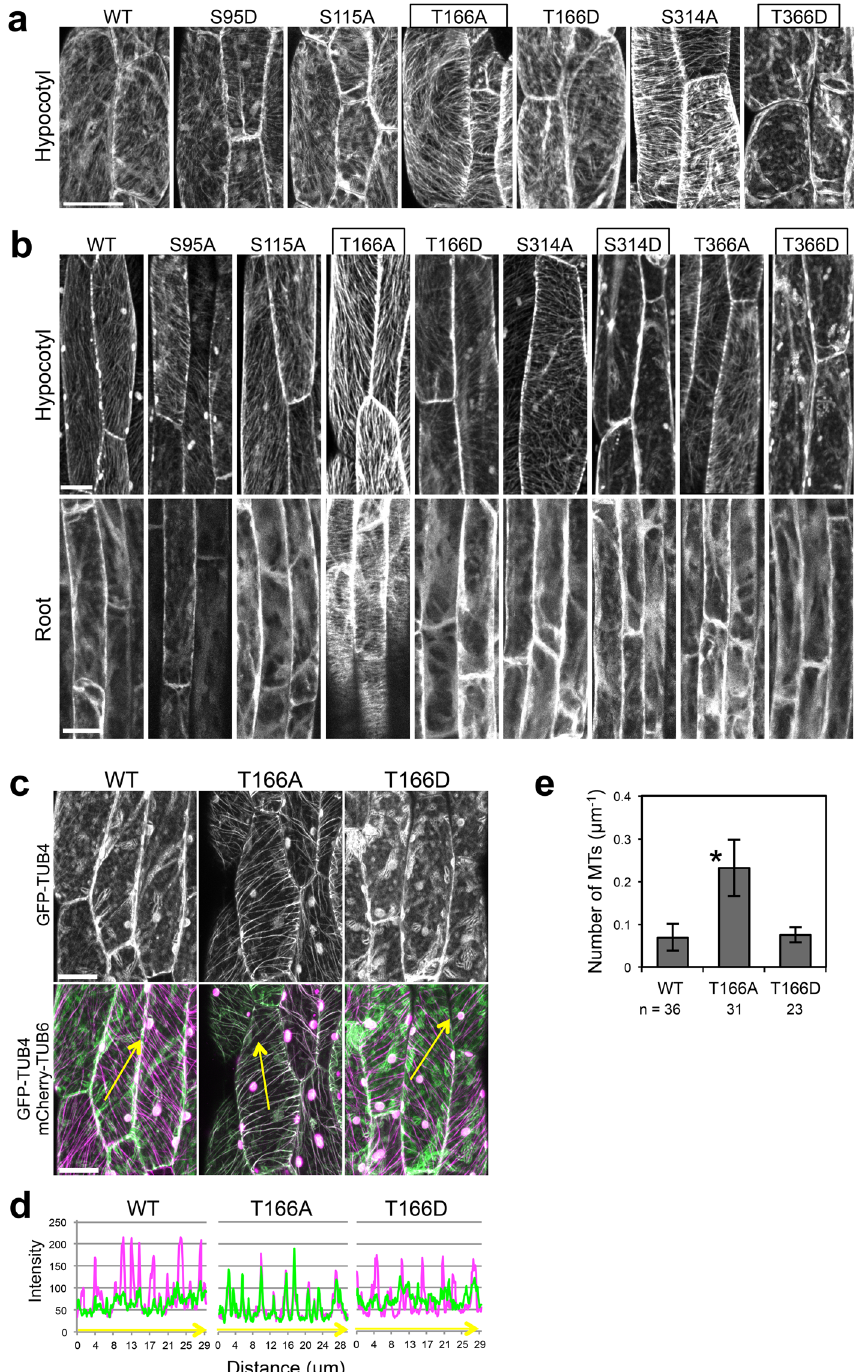
Figure 7. Involvement of Thr166 of β -tubulin in cortical microtubule depolymerization. ( a , b ) Subcellular localization of wild type TUB4 (WT) and mutated TUB4 proteins (S95A, S115A, T166A, T166D, S314A, S314D, T366A and T366D) fused with GFP at the N-terminus. GFP-TUB4 was constitutively driven by the CaMV35S promoter in ( a ) ( 35S:GFP-TUB4 ) or expressed under the TUB4 own promoter in ( b ) ( TUB4pro:GFP-TUB4 ). The scale bars represent 30 µ m in ( a ) or 20 µ m in ( b ). ( c ) Subcellular localization of wild type TUB4 (WT) and mutated TUB4 proteins (T166A or T166D) fused with GFP at the N-terminus (green). Cortical microtubules are visualized with mCherry-TUB6 (magenta). The scale bars represent 20 µ m. ( d ) Profiles of fluorescence intensity of GFP and mCherry along lines shown in ( c ). ( e ) Density of microtubules labeled with the wild type TUB4 (WT) or mutated TUB4 (T166A or T166D) fused with GFP. Data are displayed as averages ± SD. The asterisk indicates significant difference from the value in wild type GFP-TUB4 ( t -test, P <